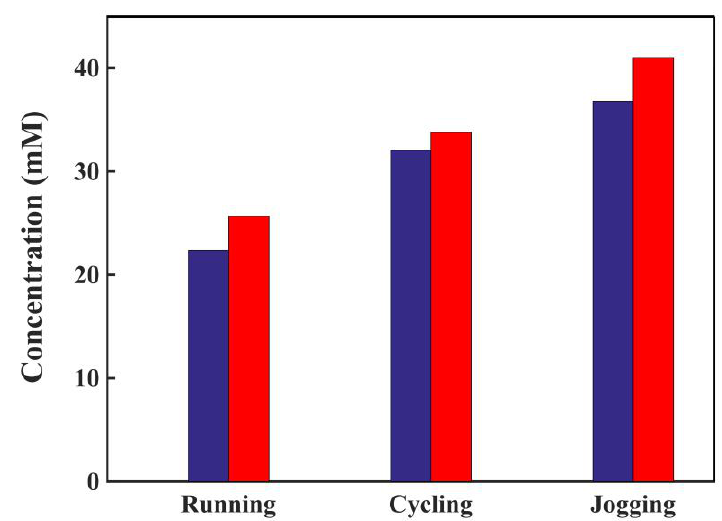
Figure 11. Blue bars: Glove sensor based on two CNT electrodes and the testing results of an Ag/AgCl electrode against real human sweat samples collected after different intensities of exercise. Red bars: Testing results of the same samples with spectrophotometers. Running: 1000 m for 4 min. Cycling: 5000 m for 20 min. Jogging: 1700 m for 12 min.